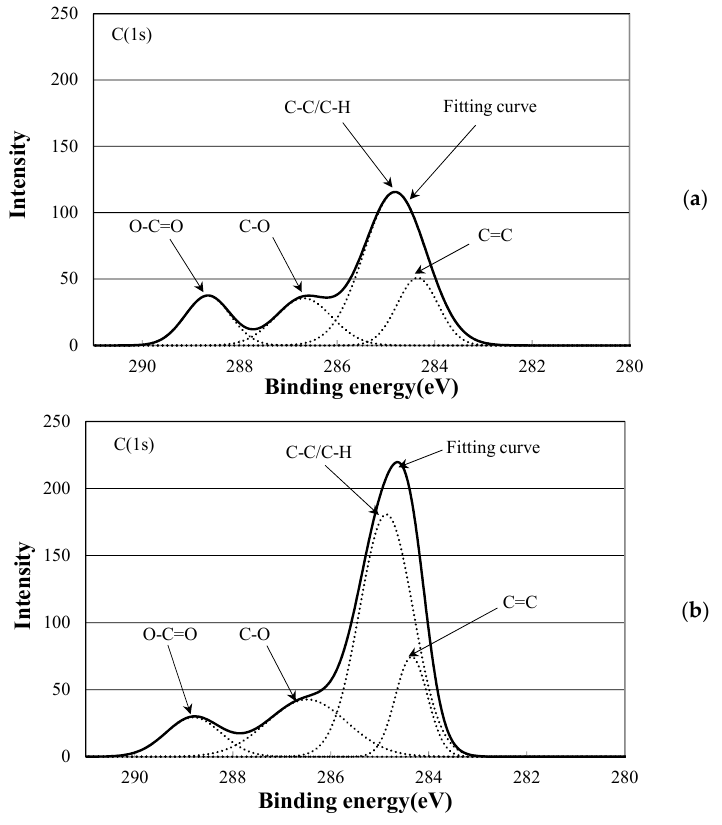
Figure 10. C1s spectrum of PLA ‐ 80 at ( a ) 0 Gy; ( b ) 100 kGy.